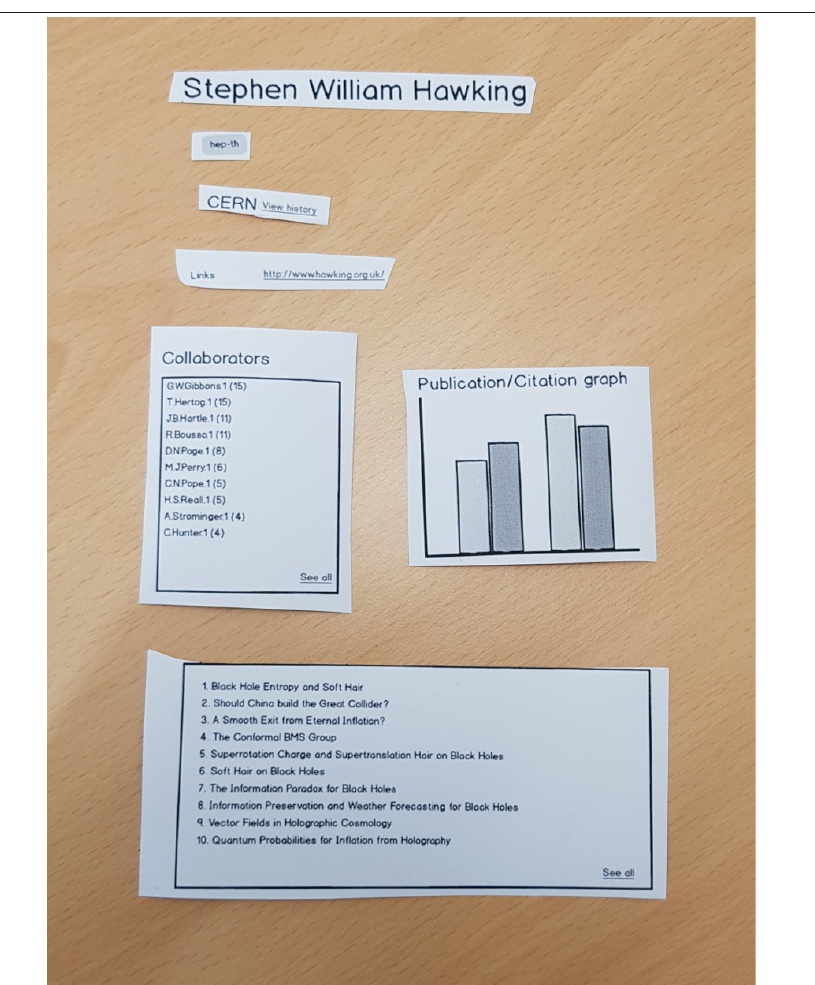
Figure 2. Author profile created by a